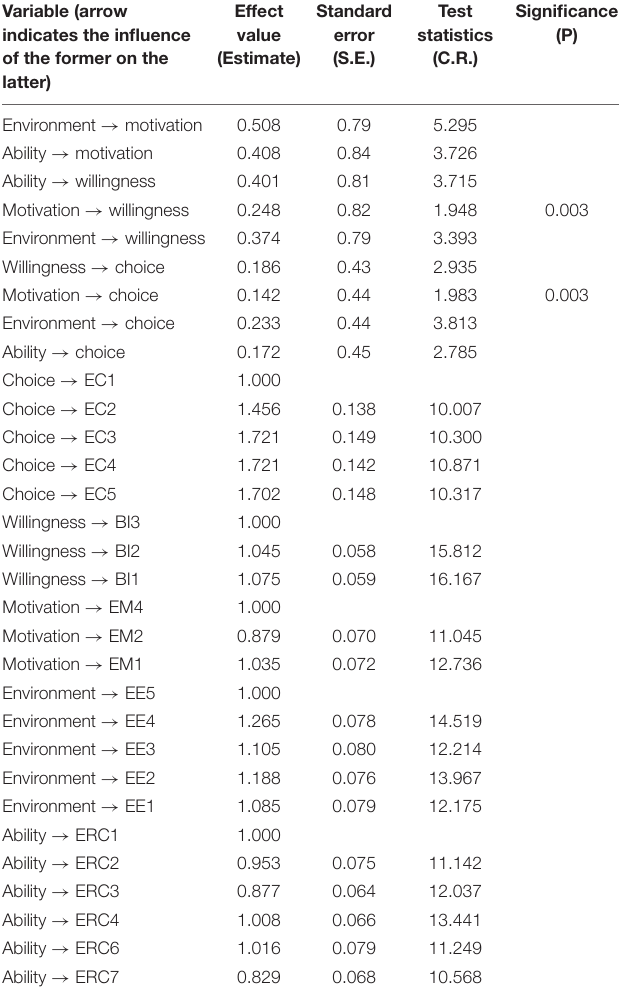
TABLE 3 | Non-standardized coefficient.